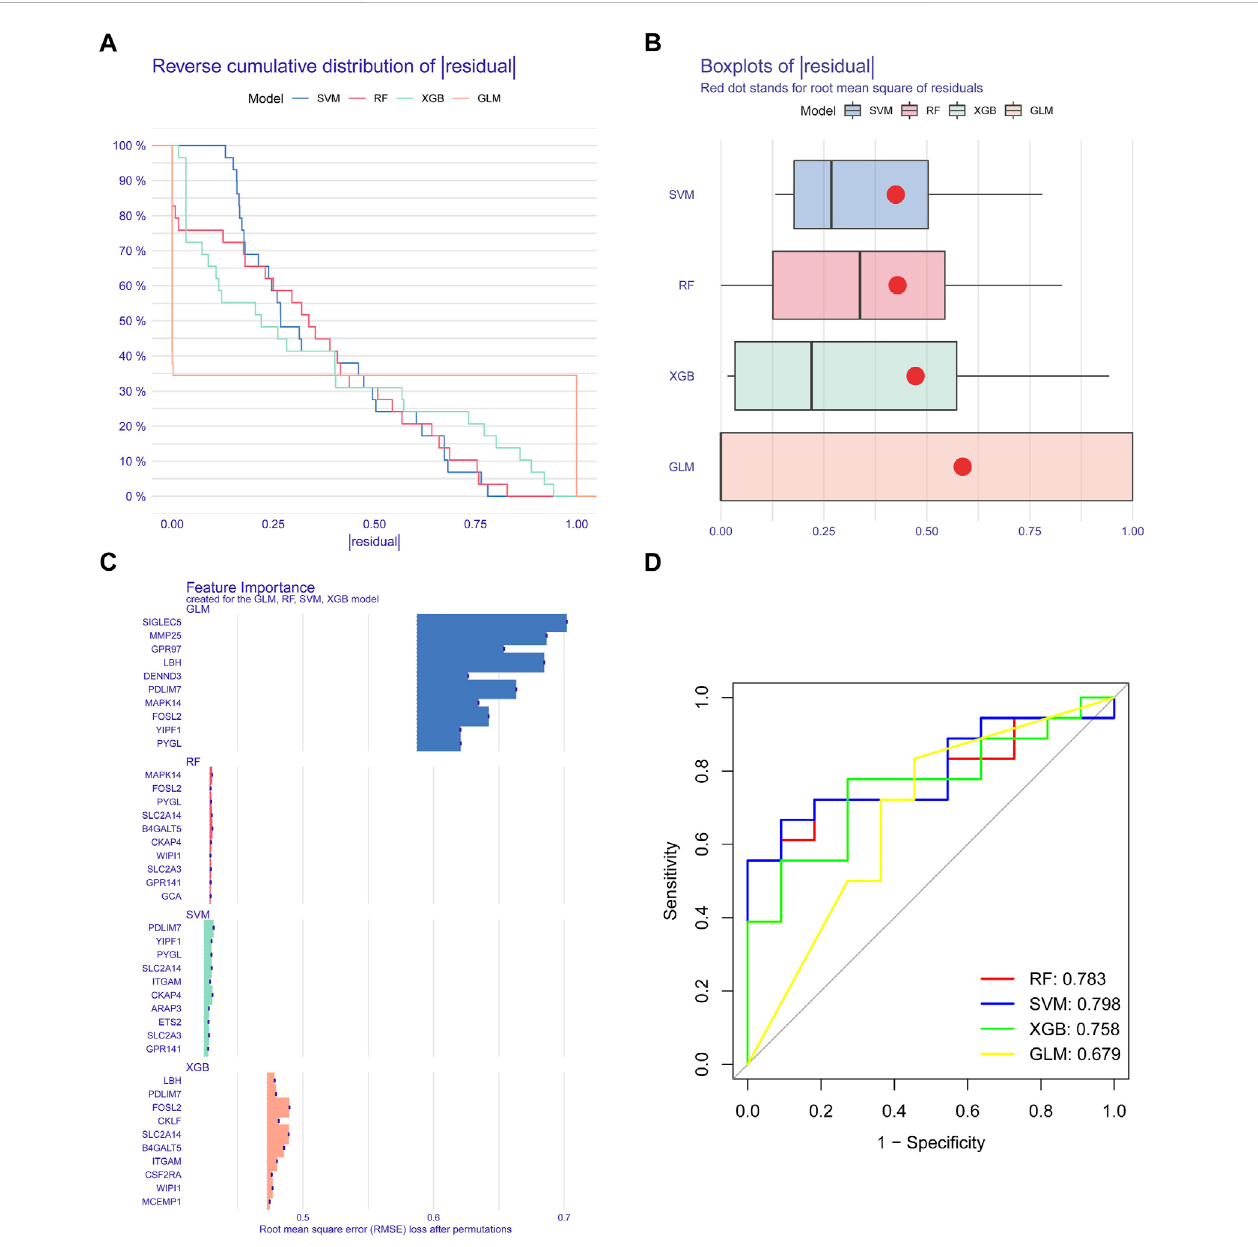
FIGURE 8 Construction and evaluation of RF, SVM, GLM, AND SGB machine models. (A) Cumulative residual distribution of each machine learning model. (B) Boxplots showed the residuals of each machine-learning model. (C) The important features in RF, SVM, GLM, and XGB machine models. (D) ROC analysis of four machine learning models based on fi ve-fold cross-validation in the testing